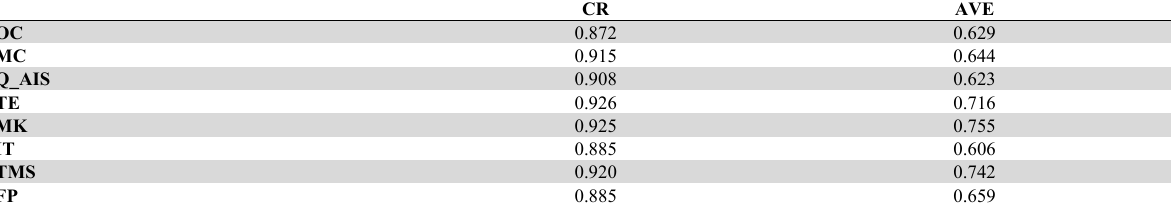
Composite reliability and Variance